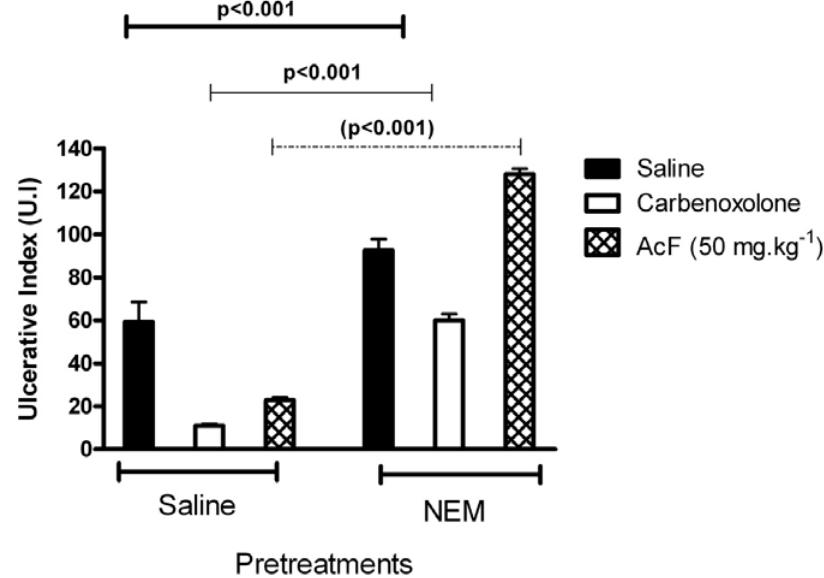
Figure 8. Effects of orally administered ethyl acetate extract (AcF; 50 mg·kg − 1 ) obtained from the leaves of A. humile St. Hil. and of carbenoxolone (100 mg·kg − 1 ) on ethanol- induced gastric ulcers in rats pretreated with